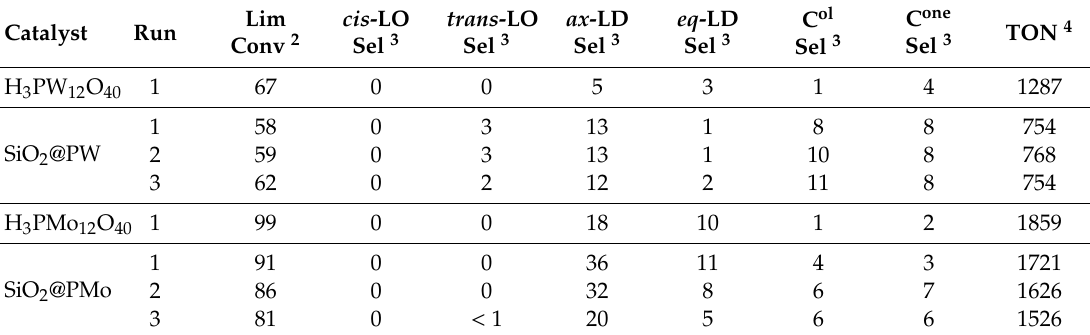
Table 5. Relevant data for the catalyzed oxidation of limonene 1.